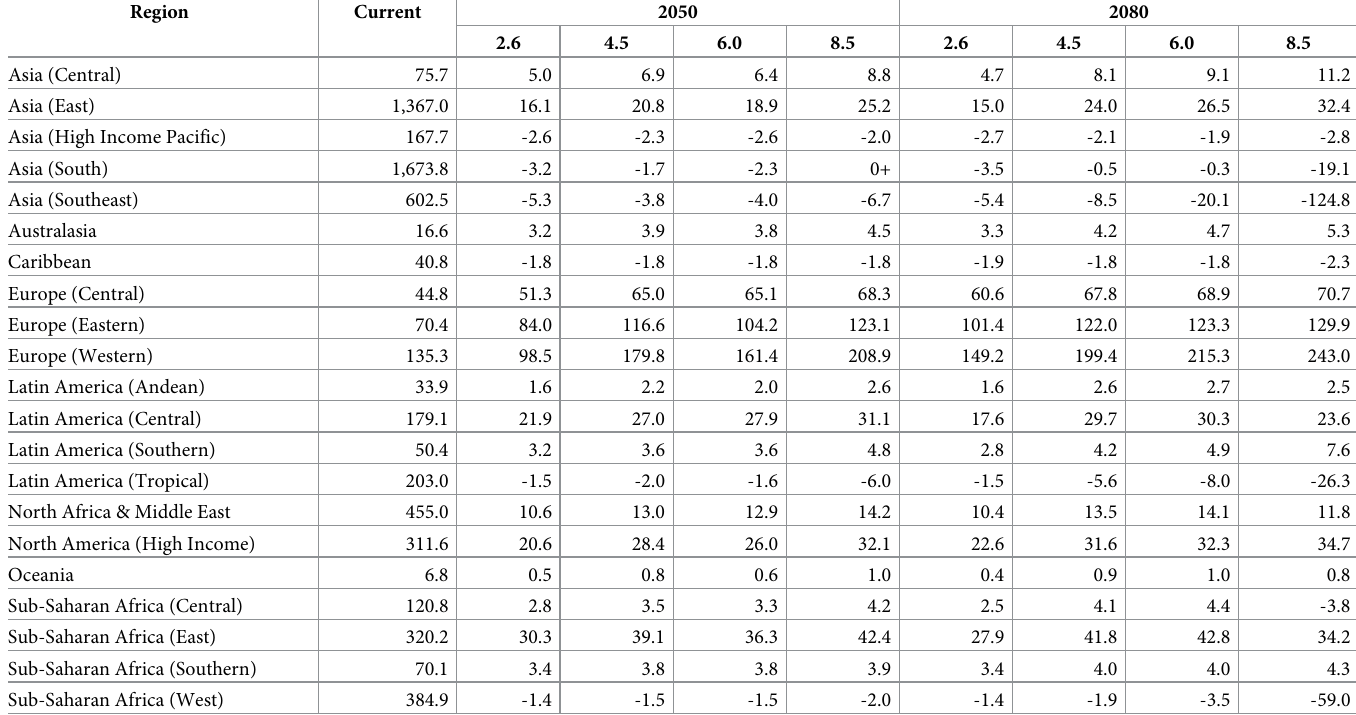
Table 2. Changing population at risk due to temperature suitability for Aedes albopictus virus transmission. All values are given in millions; future projections are averaged across GCMs, broken down by year (2050, 2080) and RCP (2.6, 4.5, 6.0, 8.5), and are given as net change from current population at risk. 0+/0- denote the sign of smaller non-zero values that rounded to 0.0, whereas “0” denotes true